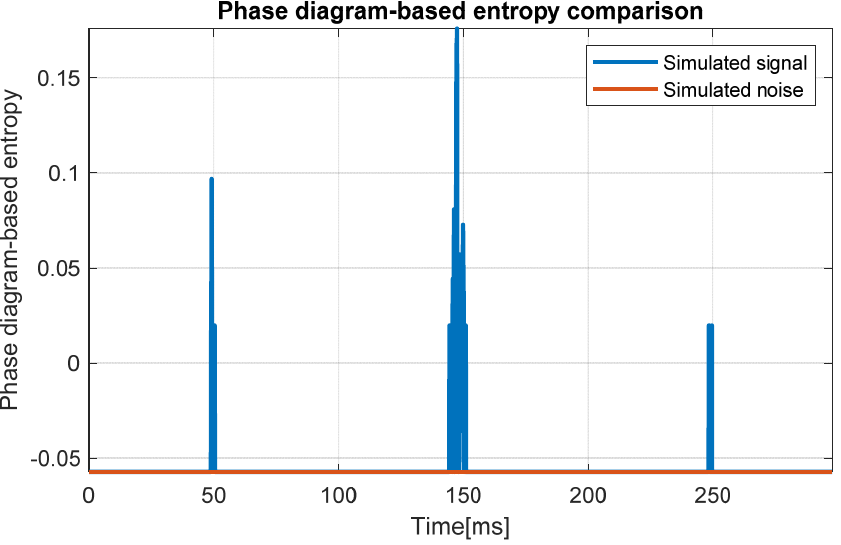
( ) ( ) var r w × = 0.2 . var r w × = 0.2 .